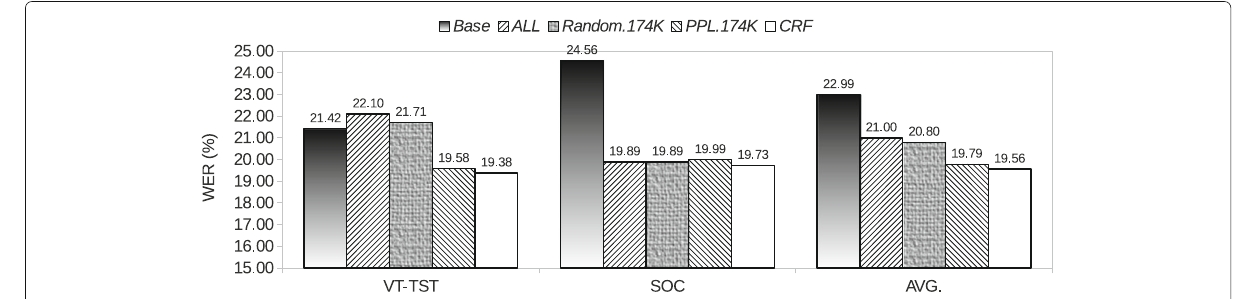
Fig. 5 Recognition performance (WER) using 174K selected sentences